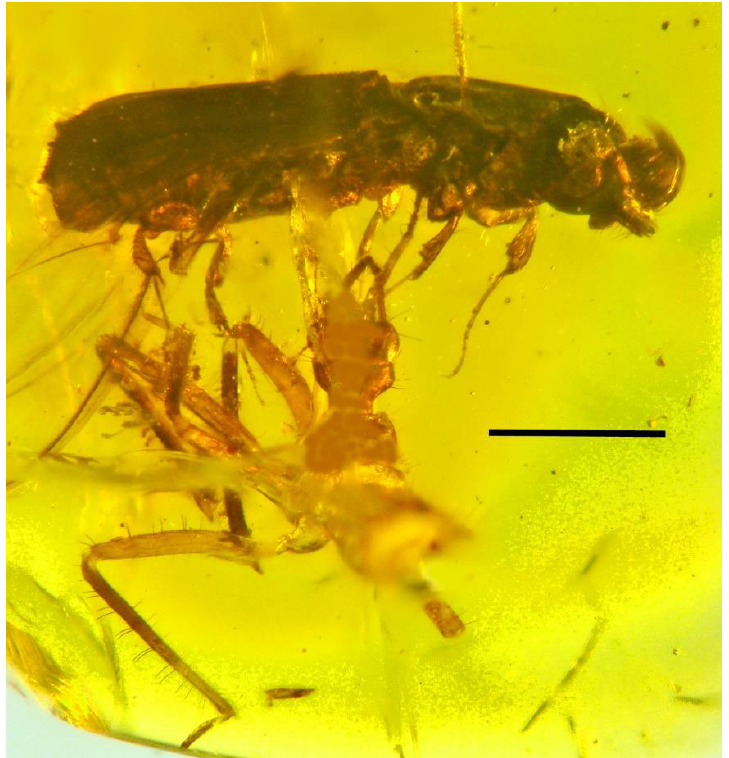
Figure 19. Reduviid (Hemiptera: Reduviidae) attacking a platypodine (Coleoptera: Curculionidae: Platypodinae) in Dominican amber. Scale bar = 1.0 mm.